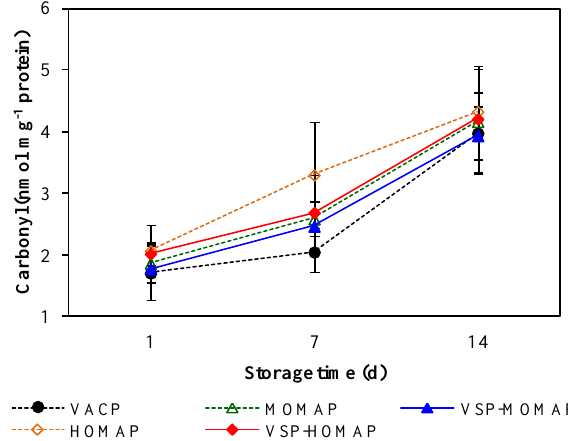
Figure 4. Carbonyl content in sliced Hanwoo (Korean cattle) beef loin in packaging systems for 14 d at 4°C. Data are presented as means±SD. VACP, vacuum packaging; MOMAP, medium oxygen-modified atmosphere packaging (50% O 2 /20% CO 2 /30% N 2 ) alone; VSP-MOMAP, MOMAP combined with vacuum skin packaging; HOMAP, high oxygen-MAP (80% O 2 /20% CO 2 /0% N 2 ) alone; VSP-HOMAP, HOMAP combined with VSP; SD, standard